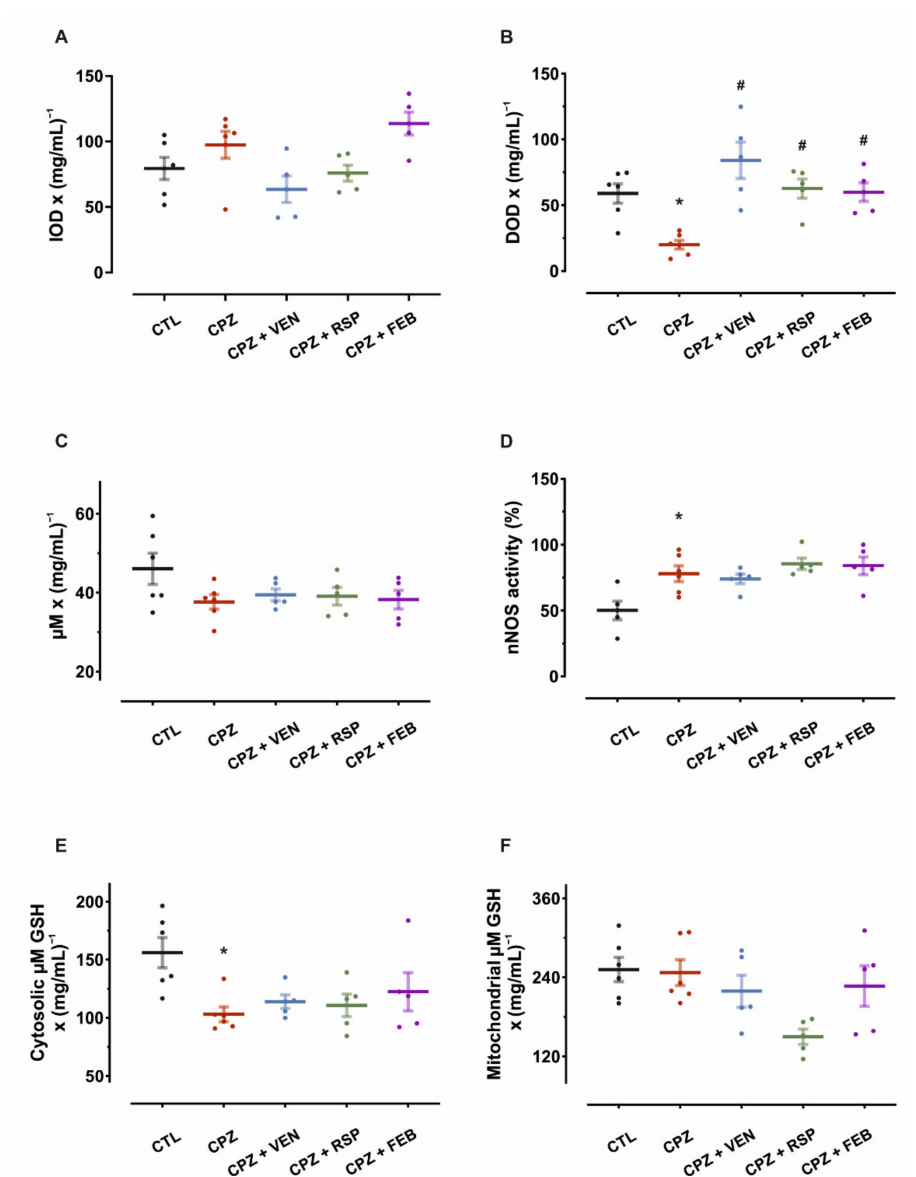
Figure 3. Results from biochemical assays of mouse brain homogenates. ( A ) Susceptibility to lipid peroxidation of the mitochondrial membrane, determined with DPPP method—percentage increase of optical density (IOD) reported to protein content, after 5 min. ( B ) Effects of 5-week treatments on mouse brain SOD activity—percentage decrease in optical density (DOD) reported to protein content. ( C ) Variation of total nitrites in mouse brain tissues—modified Griess method. No significant variations of total nitrites were observed between groups. ( D ) nNOS activity (percentage increase of total nitrites when nNOS activity is assessed). ( E ) Cerebral cytosolic total thiols concentrations, expressed as glutathione (GSH) equivalents to protein ratio. ( F ) Mitochondrial total thiols. Data are presented as means ± S.E.M. CTL—control ( n = 6); CPZ—cuprizone 400 mg · kg − 1 ( n = 6); CPZ + VEN—cuprizone 400 mg · kg − 1 and venlafaxine 60 mg · kg − 1 ( n = 5); CPZ + RSP—cuprizone 400 mg · kg − 1 and risperidone 2 mg · kg − 1 ( n = 5); CPZ + FEB—cuprizone 400 mg · kg − 1 and febuxostat 5 mg · kg − 1 ( n = 5). * p < 0.05 vs. CTL; # p < 0.05 vs.